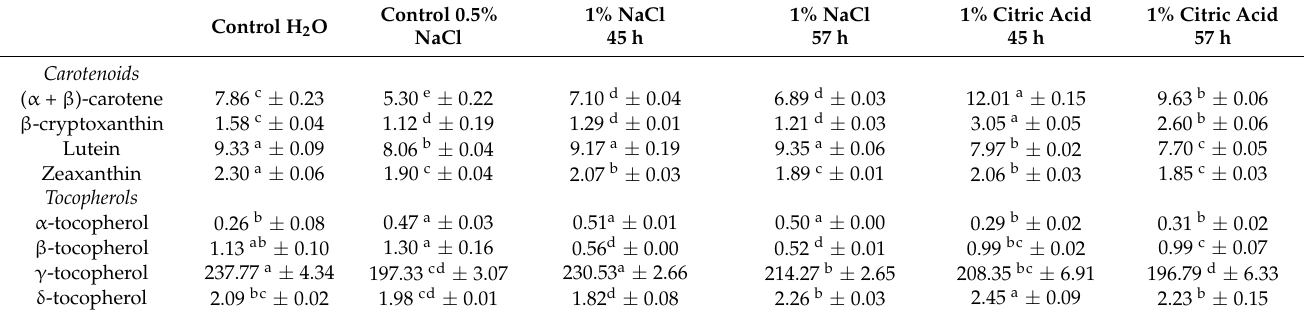
Table 3. Tocopherol and carotenoid content (mg/kg DM; mean ± standard deviation) in Lupinus albus seeds (Lot 2) debittered by the control methods with water (Erba¸s [28], modified by C ó rdova-Ramos et al. [27]) or with 0.5% NaCl [31] and the experimental method with different solvents